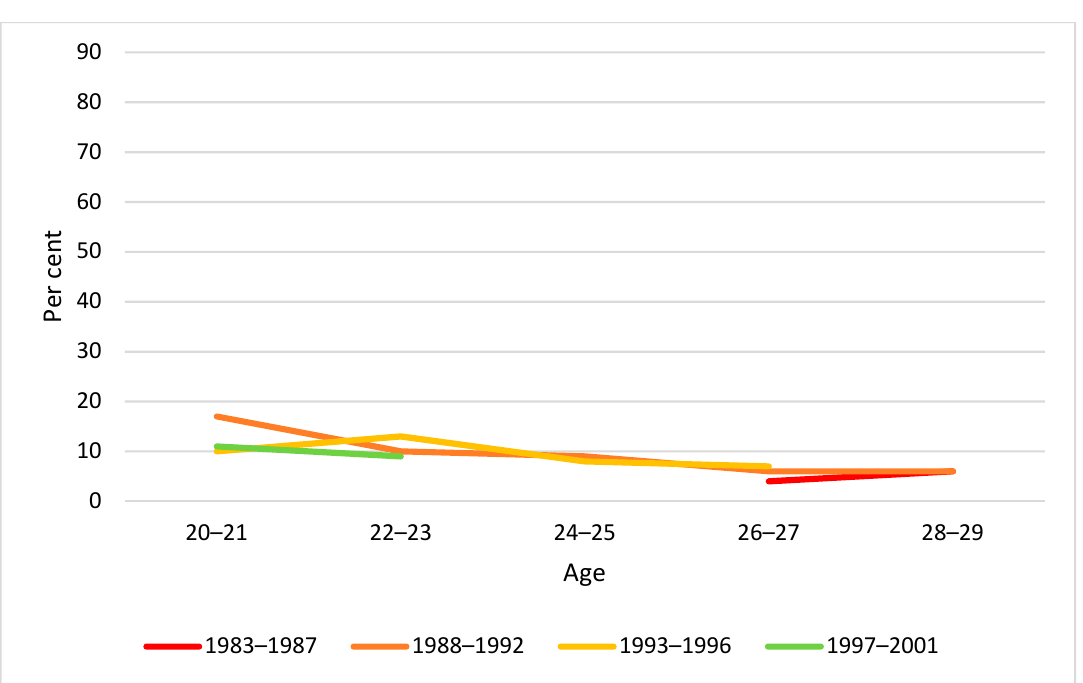
Figure 6. Proportion monthly HED by birth cohort and age. Note: None of the cohort differences at any age were statistically significant ( p > 0.05).